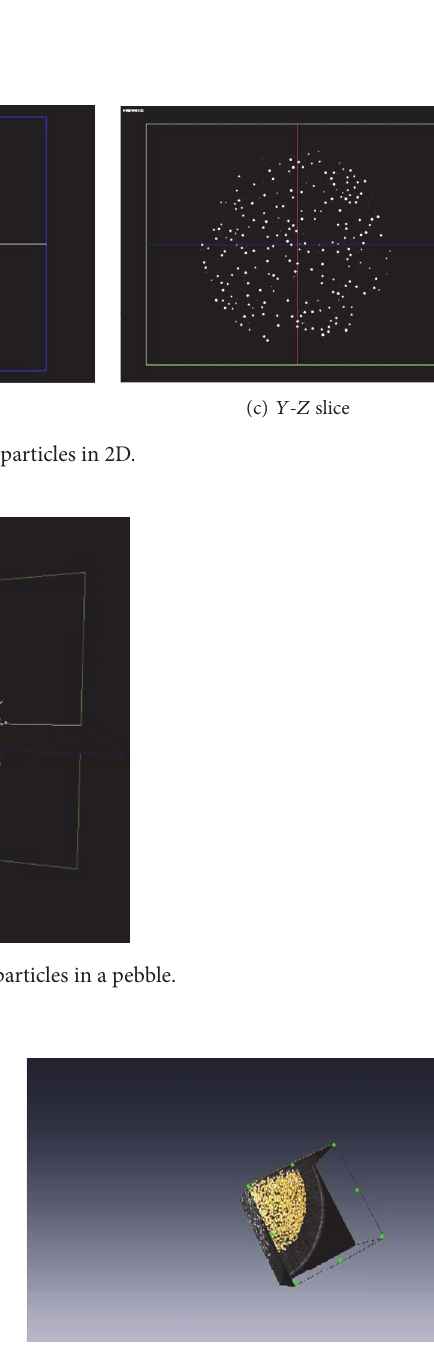
Figure 9: Illustration of animated 3D visualization of 3D slices of fuel